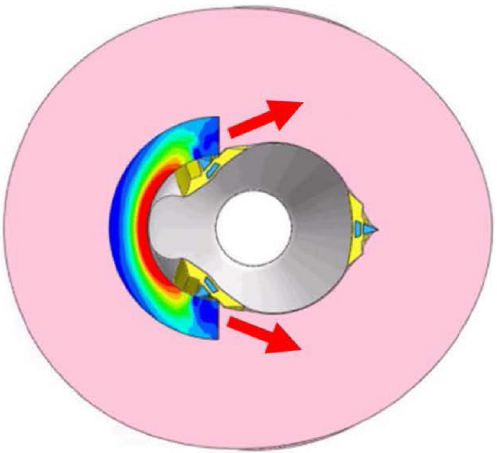
Fig 7. Incidence of slippage during the inflation of balloons of diameters 2 and 2.25